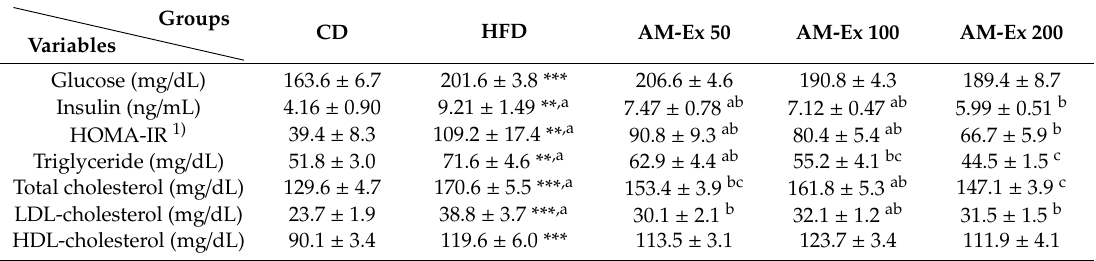
Table 3. E ff ect of AM-Ex on insulin resistance and serum lipid levels in HFD-fed C57BL / 6N mice.